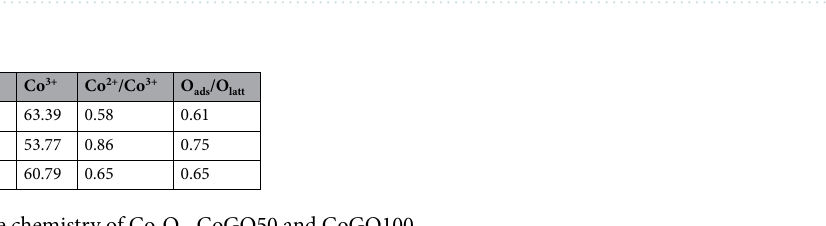
Table 1. Surface chemistry of Co 3 O 4 , CoGO50 and